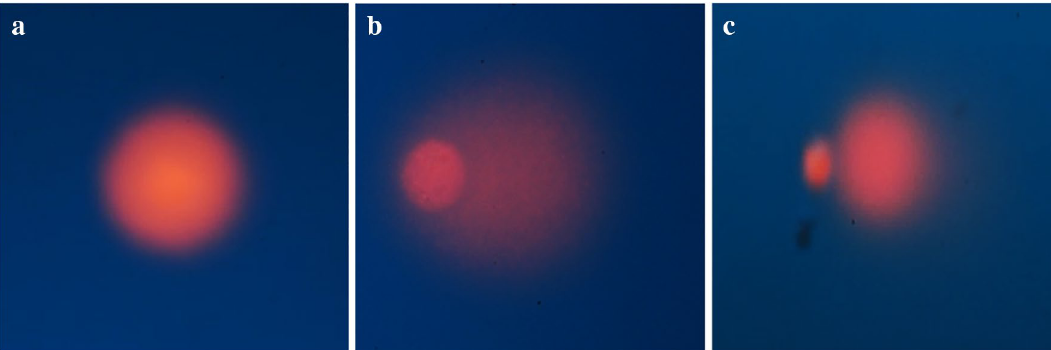
Figure 8. Representative pictures of alkaline comet assay (evidence of SSBs and DSBs): ( a ) DMSO—control Caco-2 cell undamaged nucleus; ( b ) VF200-treated Caco-2 comet; ( c ) VF200-treated HepG-2 comet. The principle of the assay is that under an electric field, fragmented DNA migrates out of the nucleoid body (also known as the "comet head") and forms a smeared DNA stain in the agarose gel (also known as the "comet tail"). Thus, the more is the comet tail (as more in b and less in c ), the more DNA is fragmented, more DNA damage is present. Conversely, the more round is the nucleoid body (as in a ), the less DNA is fragmented, less DNA damage is present. By CASP software (Biotools) it can be calculated the parameter “tail moment” to quantitatively express this nutrigenomic approach and its informative potential were performed to clarify the cytotoxic effects showed by (±)- trans -δ-viniferin. We also used compounds with a known demethylating effect such as 5-AzaC and B339H, as positive controls. It is known that 5-AzaC inhibits DNA methylation 22 by a negative interaction with the methyl donor S-adenosine- methionine (SAM). B339H, a recently synthesized molecule, determines changes in DNA methylation by an indirect action of inhibition of TET enzymes, without inhibiting DNMT3A. In particular, a 33 μM treatment yields data relating to the inhibition of the TET1 enzyme alone and a 75 μM dose provides information about the inhibition of both enzymes 23 . Interestingly, the cell lines treated with these two molecules (culture acronym AZA, B33 and B75), appeared with morphological alterations. Similarly, cells treated with (±)- trans -δ-viniferin (Figs. 2 and 3) showed morphological alterations. Prompted by this analogous behavior, we evaluated the epigenetic/ epigenomic potential of (±)- trans -δ-viniferin and we found that it significantly modified the DNA methylation of the cells (Table 1, Figs. 5 and 6). In fact, in Caco-2 and HepG-2 cell lines variations of the band pattern were found significantly different in comparison with the cells with DMSO vehicle. Remarkably, these values were very similar to those obtained, in both cell lines, with 5-AzaC, suggesting that (±)- trans -δ-viniferin most likely increases DNA demethylation via SAM-DNMTs interaction. In addition, by treating cells with B339H, which promotes TET enzymes inhibition, we found a sustained genomic DNA demethylation with different behavior in Caco-2 and HepG-2 cells. At the concentration inhibiting both the TET enzymes (75 μM), Caco-2 cells showed a high increase of DNA demethylation while HepG-2 showed the same behavior at both the doses with a greater effect at 33 μM concentration, which should give the inhibition of TET1 enzyme only. Since treatments with 5-AzaC, (±)- trans -δ-viniferin and B339H showed similar effect, we can affirm that (±)- trans -δ-viniferin acts as a demethylating agent. An issue remains open: the increase in demethylation of genomic DNA in the presence of B339H that inhibits TET enzymes. Further studies will need to be carried out to clarify these intriguing char- acteristics. B339H is a molecule that has only recently been put on the market, consequently there are very few published studies in which it has been used. We also investigated the ability of selected stilbenoids to counteract the effects of a frequent and unavoidable epigenetic insult for humans, like arsenic, a non-metal with high envi- ronmental pervasiveness, introduced daily through drinking water in micromolar concentrations, whose mode of action is still unclear 24 . In order to show what might happen in a normal intestinal cell model in vitro and offer a projection of what likely occurs in vivo, we submitted Caco-2 cells to a combined treatment (a pre-treatment with SA, followed by a treatment with stilbenoids). To the best of our knowledge, this is the first study of such a combined treatment. As expected, the treatment with SA caused remarkable alterations in the cell morphology, with small size and not adherent cells (Fig. 4b). Interestingly, in the subsequent addition of stilbenoids (Fig. 4c–h), reversed in a relevant percentage, the morphological damage induced by SA insult, so that the cells reverted the phenotype like control ones. In addition, more interesting are the results regarding DNA methylation, also gained by the combined treatments (Fig. 7). According to the literature 25 , pre-treatment of Caco-2 cells with SA induces DNA demethylation. When pre-treatment with arsenic is followed by treatment with stilbenoids, using concentrations similar to those they would have in the intestinal lumen, the global methylation levels of DNA was similar or even slightly lower than the control ones (Table 2). The atypical behavior of (±)- trans -δ-viniferin in regard of DNA methylation, prompted us to investigate whether this stilbenoid is also able to induce DNA damage, since the relationship between chromatin modifi- cations and double-strand break signaling and repair is well known 26 . By carrying out alkaline comet test, we highlighted that (±)- trans -δ-viniferin showed a dose-dependent cytogenotoxic effect at both concentrations in both the cell lines (Table 3; Fig. 8) with a peculiar difference for the HepG-2 cells for which the OTM variation induced in VF200 is significantly greater compared to the control with DMSO (Fig. 8c).